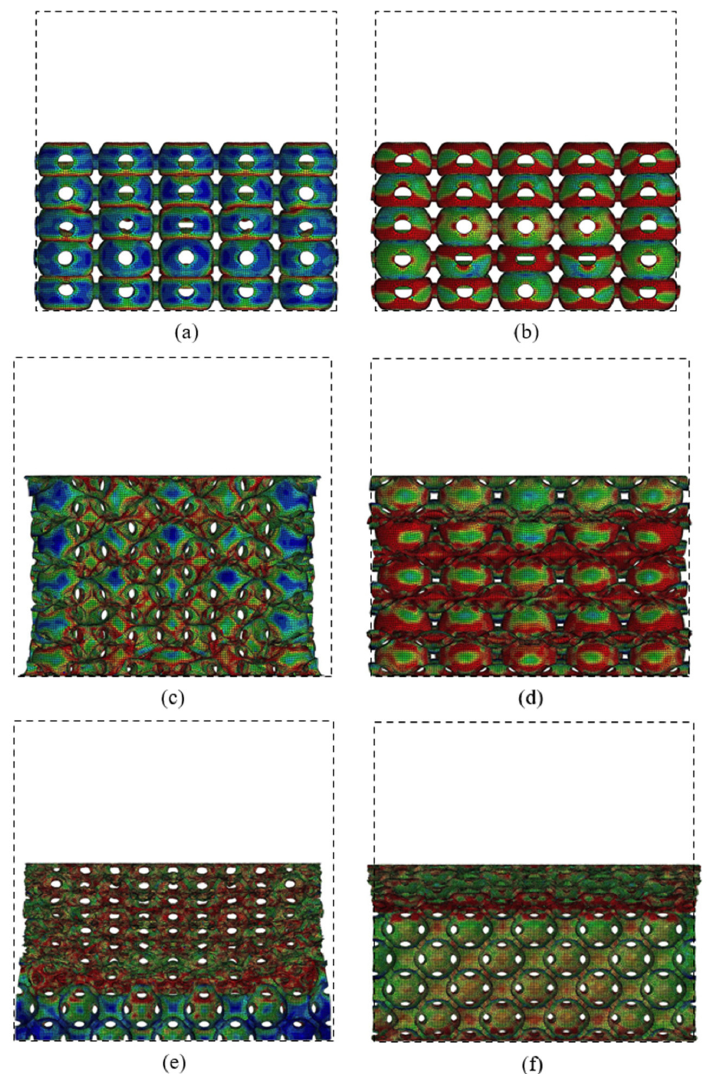
Figure 10. Deformations of SC structure with the ( a ) smallest and ( b ) largest wall thicknesses at a strain of 43%; deformations of BCC structure with the ( c ) smallest and ( d ) largest wall thicknesses at a strain of 37%; deformations of FCC structure with the ( e ) smallest and ( f ) largest wall thicknesses at a strain of